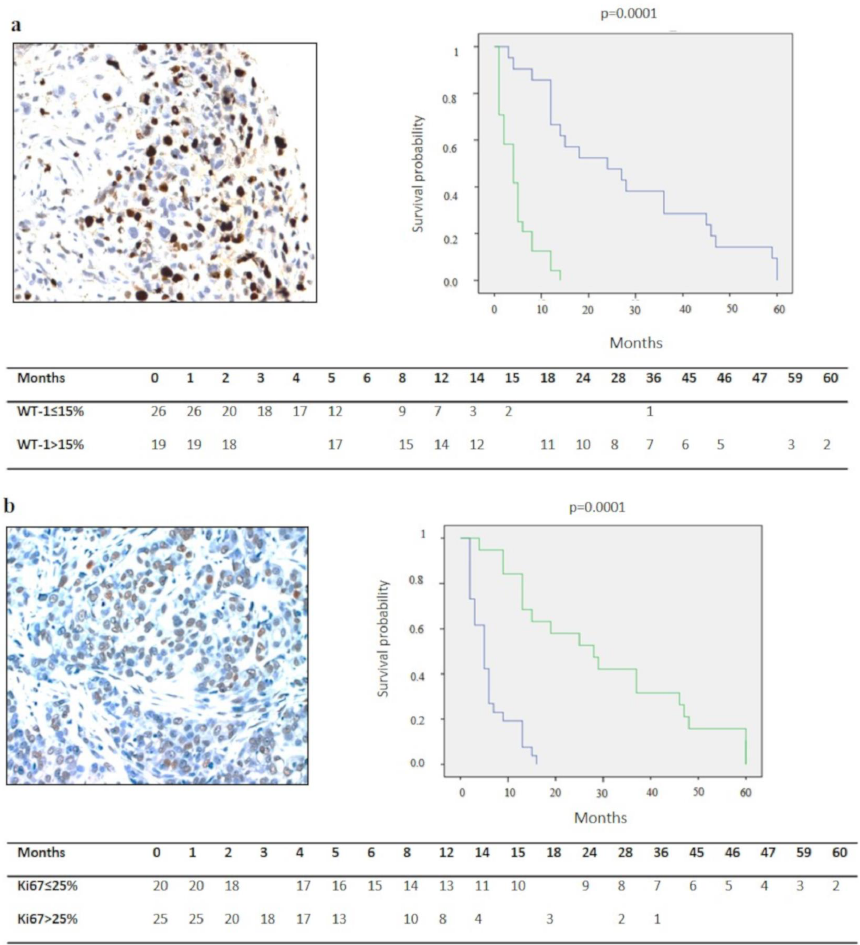
Figure 1. Correlation between histological variables and survival. Sarcomatoid histotype (hematoxylin and eosin stain, original magnification × 200). ( a ), nuclear grade 3 (hematoxylin and eosin stain, original magnification × 200); ( b ), mitotic count > 5 x mm 2 (hematoxylin and eosin stain, original magnification × 200); ( c ) and prominent desmoplastic stromal reaction (hematoxylin and eosin stain, original magnification × 400); ( d ) showed a shorter survival when compared with their counterparts (Green lines for: biphasic histotype in ( a ), nuclear grade 3 in ( b ), mitotic count > 5 x mm 2 in ( c ), absence of desmoplasia in ( d ). Blue lines for: epithelioid histotype in ( a ), nuclear grade 2 in ( b ), mitotic count ≤ 5 x mm 2 in ( c ), presence of desmoplasia in ( d ). Yellow line for sarcomatoid histotype in ( a )). Diagnostics 2020 , 10 , x FOR PEER REVIEW